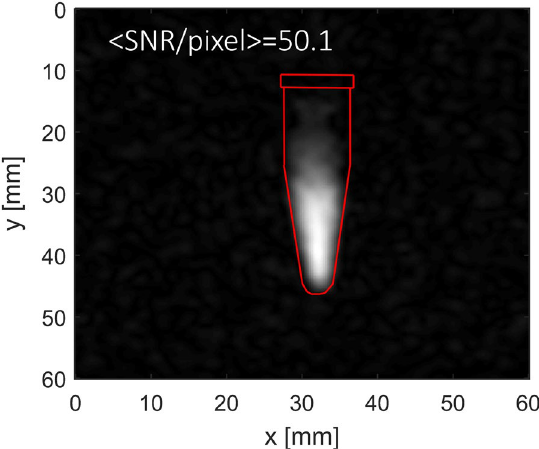
Figure 5. Image of 30 mg of functionalized silicon nanoparticles dispersed in 500 μ l of water. The sample was polarized for t = 8 h. The image was taken immediately after transfer of the sample to the imaging system. The red overlay indicates the outline of the water vial into which the silicon was